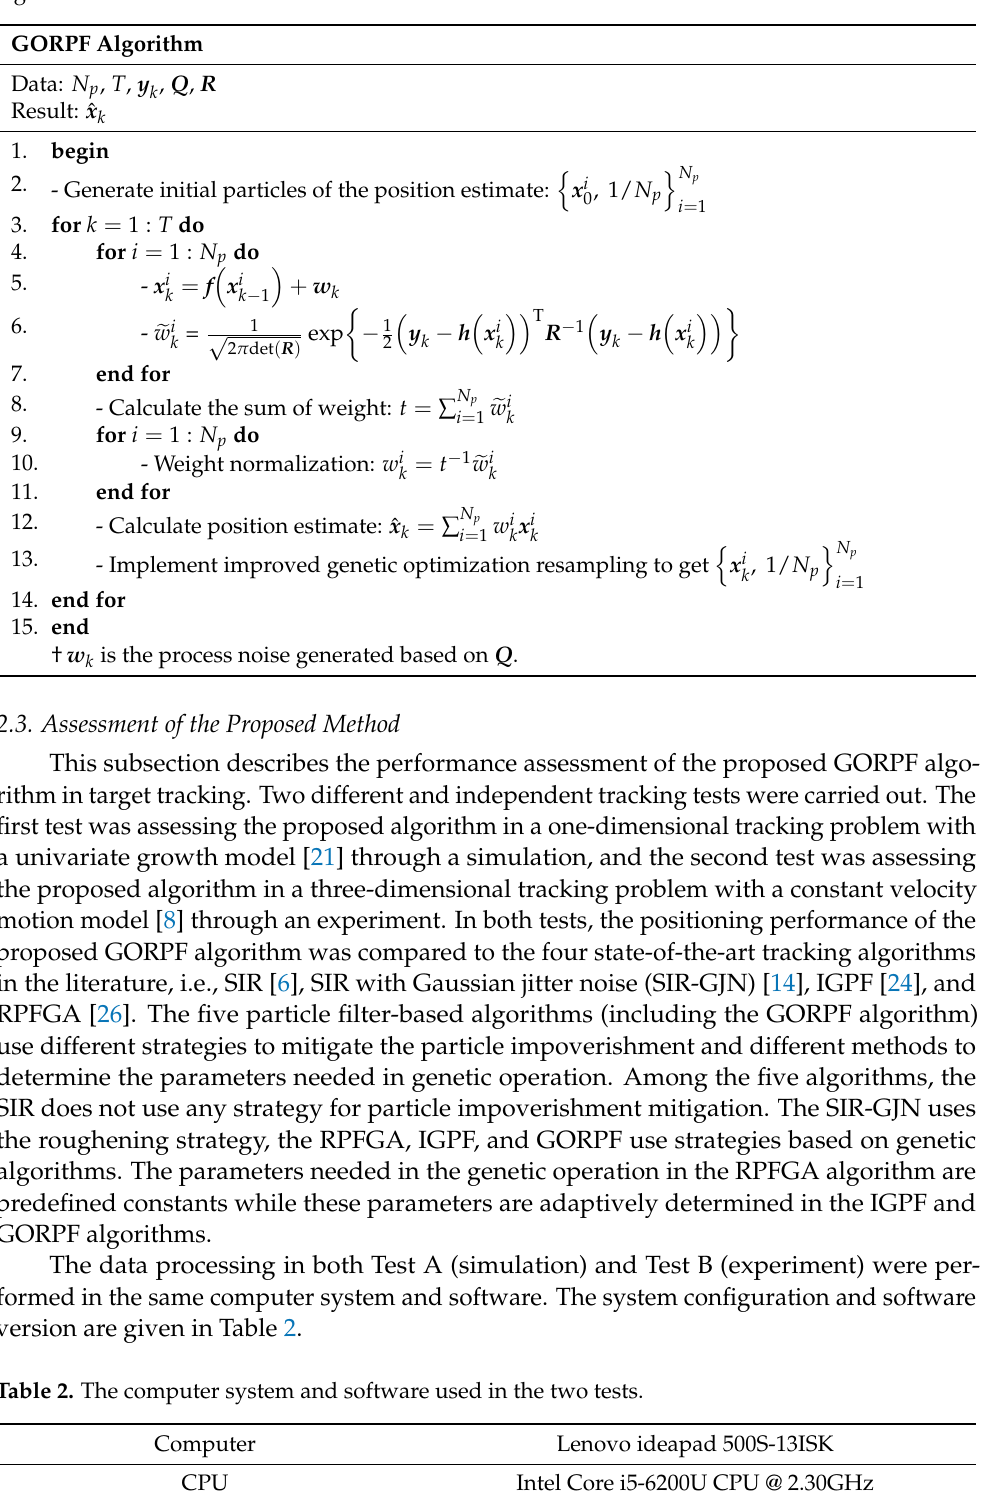
Table 1. The procedure of the genetic optimization resampling based particle filtering (GORPF) algorithm.